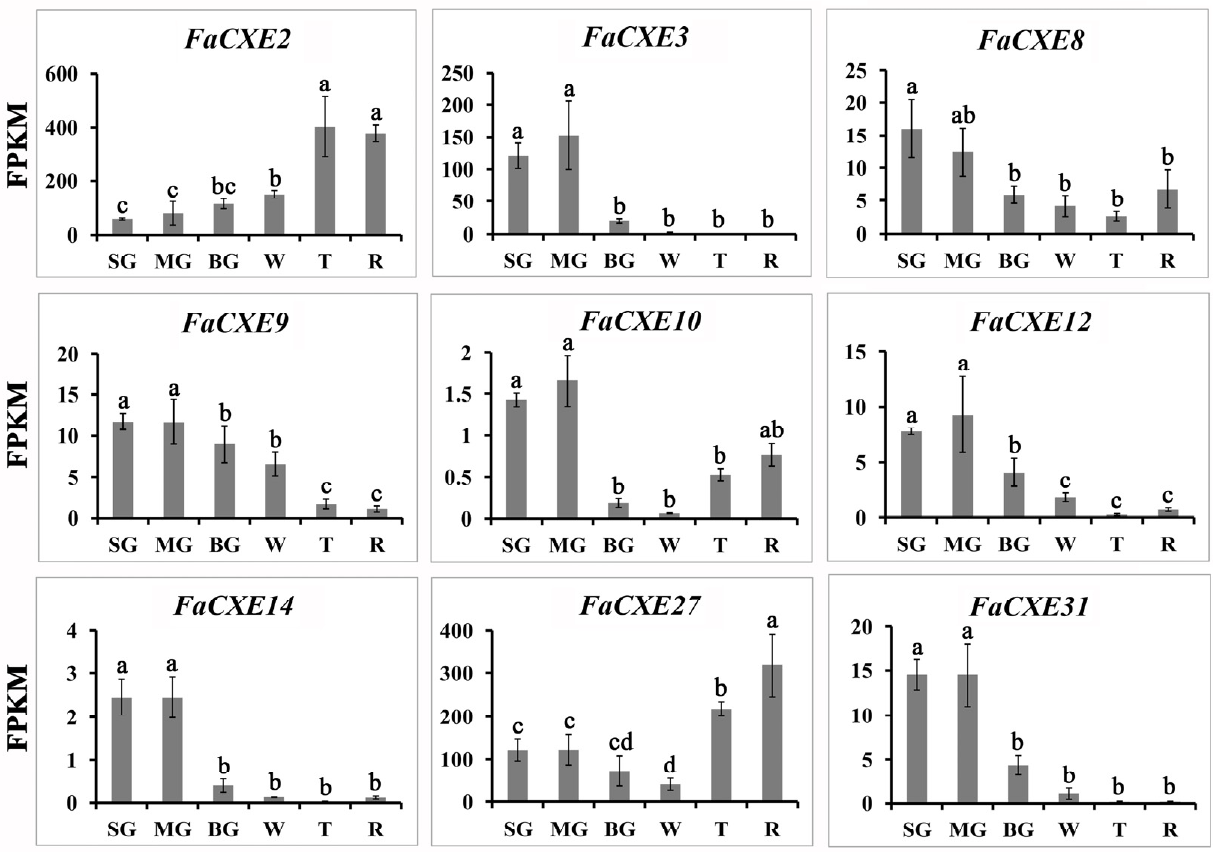
Figure 6. Expression levels of FaCXEs in strawberry fruits at different maturation stages. All data are presented as mean of three biological replicates and each error bar indicates ± SE. Lowercase letters indicate significant differences at p < 0.05.